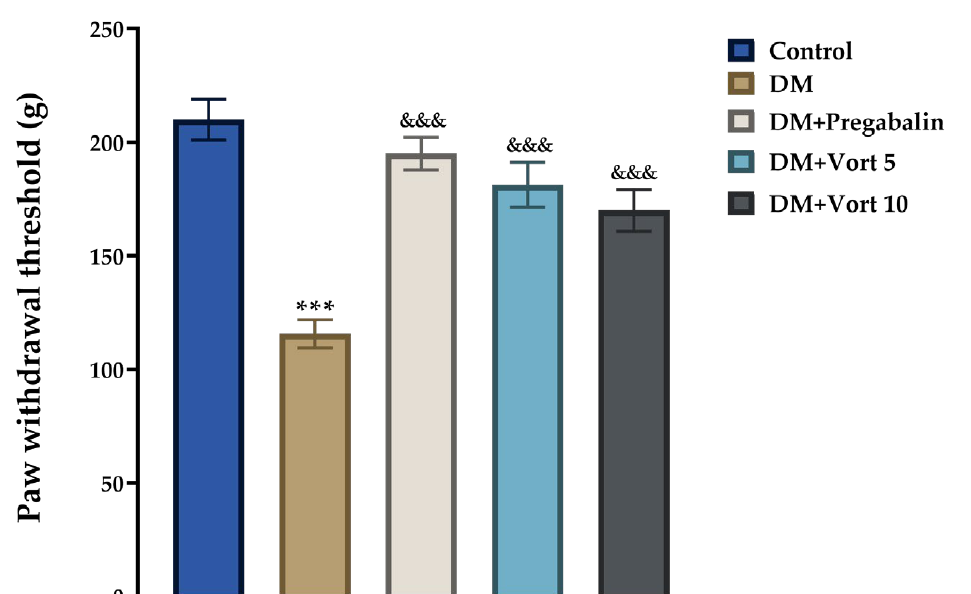
Figure 4. Paw withdrawal thresholds of normoglycemic rats administered with saline solution (control) and diabetic rats administered with saline (DM), 10 mg/kg pregabalin (DM + Pregabalin), 5 mg/kg vortioxetine (DM + Vort 5) or 10 mg/kg vortioxetine (DM + Vort 10) in the Randall–Selitto test. Values are given as mean ± S.E.M. Significant difference against control group *** p < 0.001; significant difference against DM group &&& p < 0.001. One-way ANOVA, post hoc Tukey’s HSD multiple comparison test, n = 8.